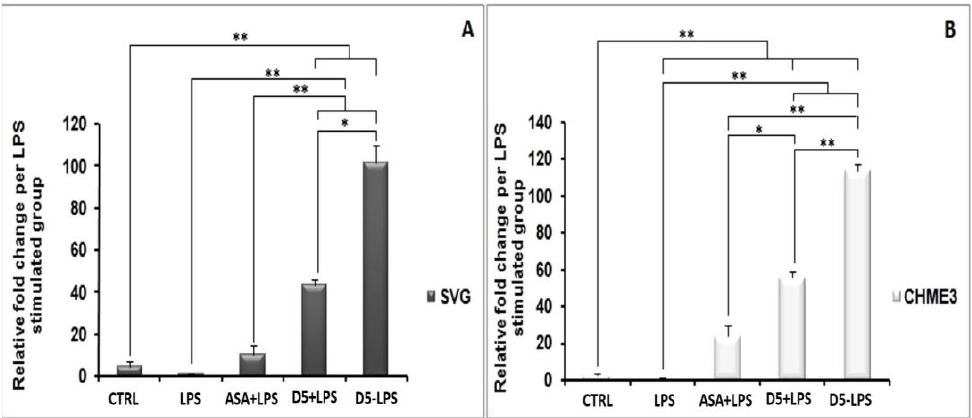
Figure 5. Up-regulation of PPAR- γ receptor expression by D5 in LPS-stimulated astrocyte (SVG) and microglia (CHME3) cell lines. ( A ) Astrocytic glial (SVG) and ( B ) microglial (CHME3) cells were treated with D5 and ASA (0.71 µM and 52.73 µM, respectively) for 2 h, and then incubated with LPS (100 ng/mL) for 24 h. Total cellular mRNA was isolated and the normalization of the optical density of individual PPAR- γ mRNA was performed usingthe corresponding levels of GAPDH mRNA. Data arepresented as the number of fold changes based on the level of PPAR- γ mRNA expression in the positive control groups of both cell lines. Data arepresented as the mean ± SD of four samples in one independent experiment. The data were replicated in three repeated independent experiments. * p < 0.05; ** p < 0.01 probability.